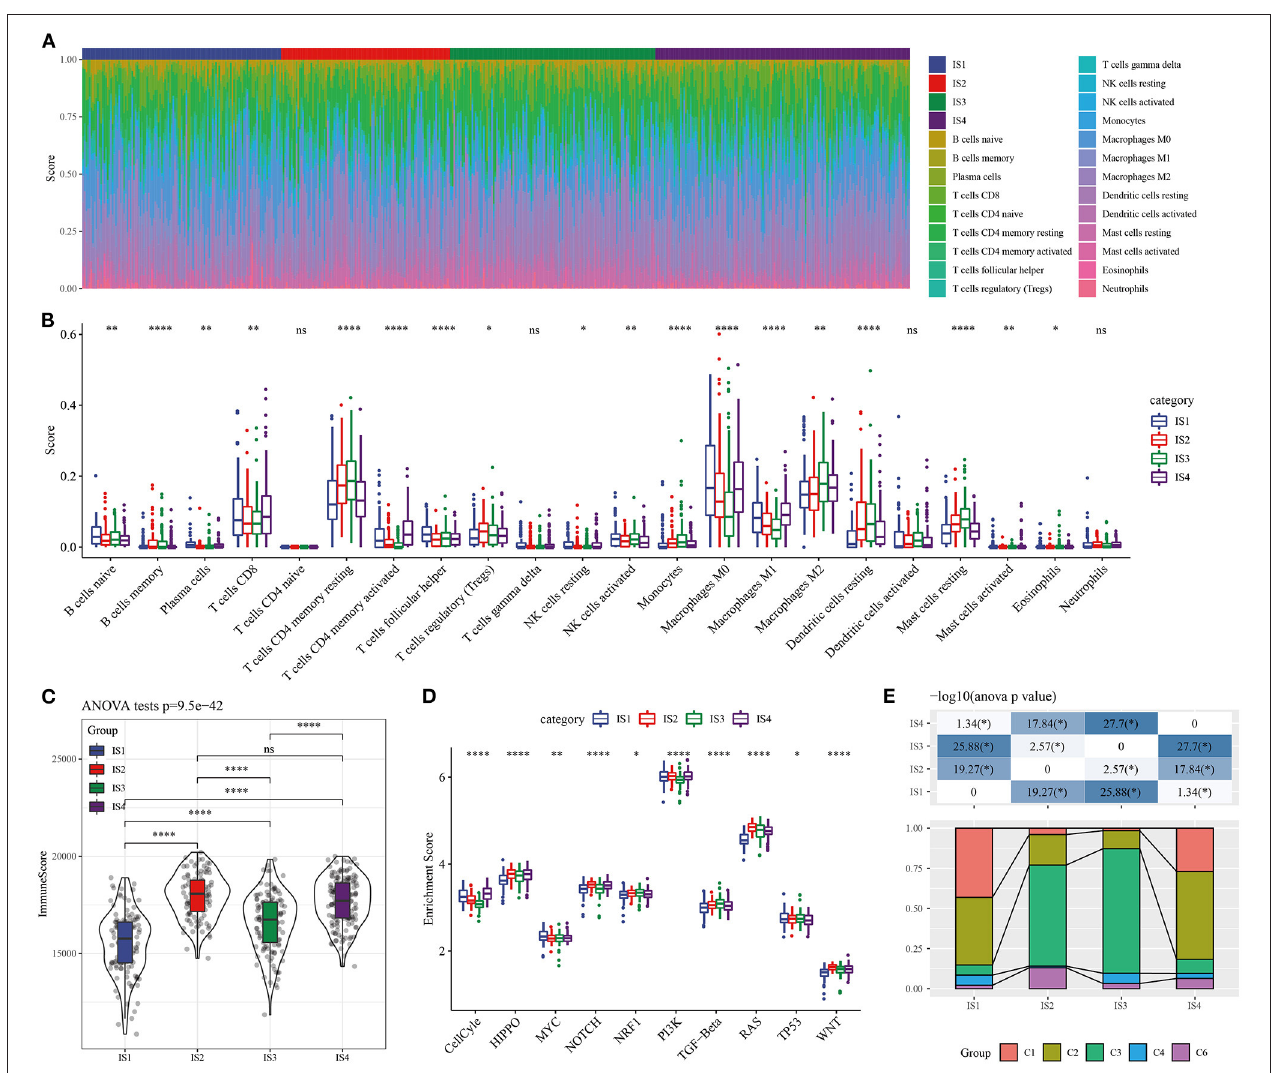
FIGURE 4 | Cellular characteristics of the ISs. (A) The distribution of 22 kinds of immune cells in ISs tissue. (B) The score of immune cell types with significant differences in two subgroups. (C) Distribution of immune scores in the four ISs. (D) Enrichment scores of four LUAD subgroups in 10 cancer signaling pathways. (E) Distribution of available immunoinfiltrating subtypes molecular subtypes in our